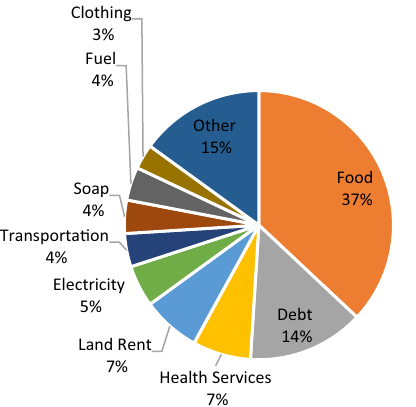
Fig. 4 Distribution of the expenditure in the district of Zahle (Bekaa) (Source: ILO